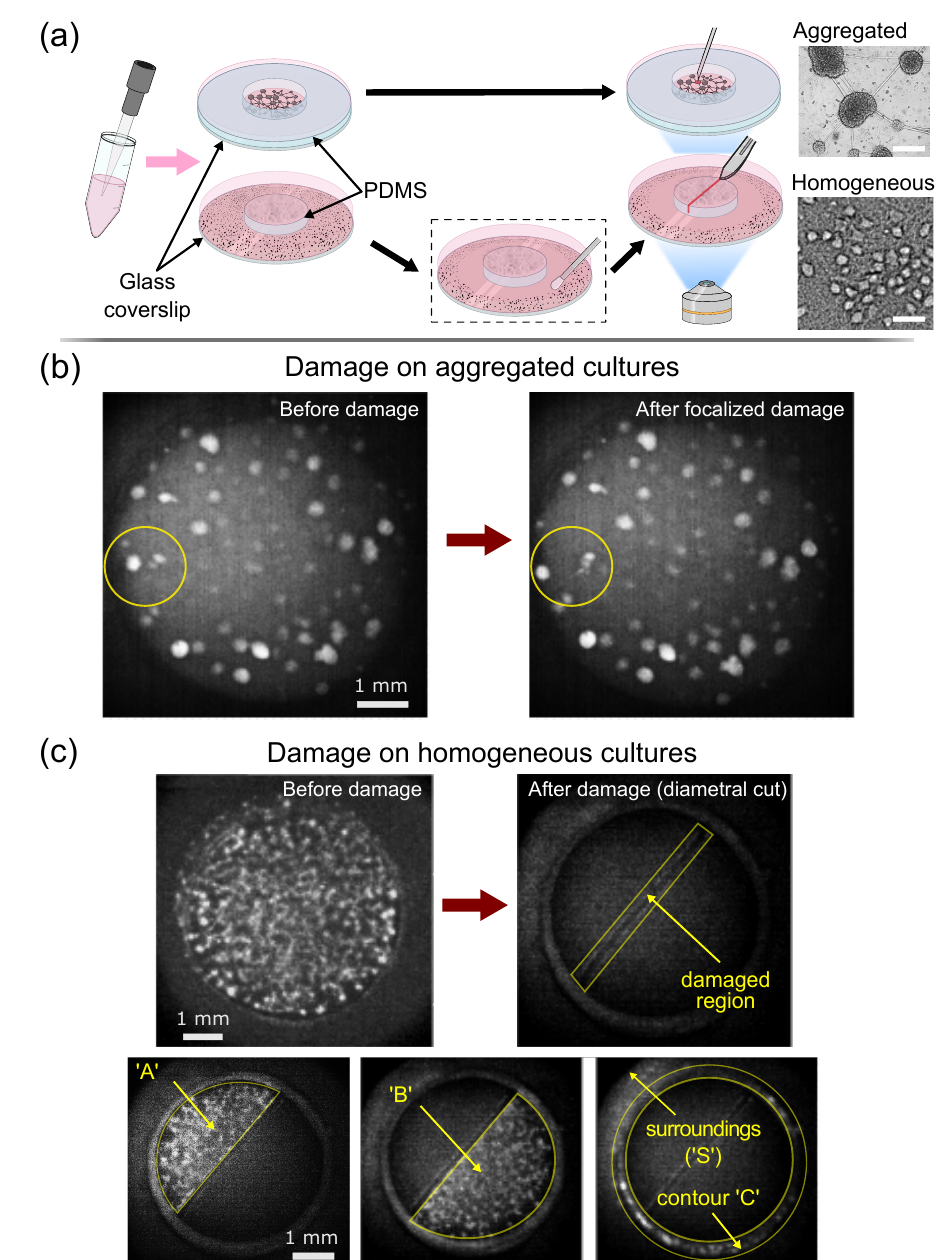
Figure 1. Neuronal cultures and experimental procedure. ( a ) Sketch of the main steps for culture preparation and damage. Neurons grown on bare glass procured ‘aggregated cultures’, in which neurons grouped in compact assemblies (bright field image on the right). These cultures were damaged using a needle. Neurons grown on PLL-coated PDMS discs provided ‘homogeneous cultures’, whose individual neurons could be discerned (bright field image). These cultures were damaged by cutting them in half along their diameter with the help of a scalpel, shaping a wound 6 mm long and 500 µ m wide. The PDMS disc was surrounded by a population of neurons that grew on glass and that could be removed if desired (black dash contour). Scale bars are 200 µ m. ( b ) Representative fluorescence images of an aggregated culture before and after damage. The yellow outline highlights the damaged region. ( c ) Representative fluorescence images for homogeneous cultures. The top snapshots show the network-wide activation of the culture before damage on the left, and the damaged region upon scalpel cut on the right. The bottom snapshots show the two halves of active neurons that appear 24 h after damage, denoted ‘A’ and ‘B’, as well as the surroundings ‘S’ and contour ‘C’ of the